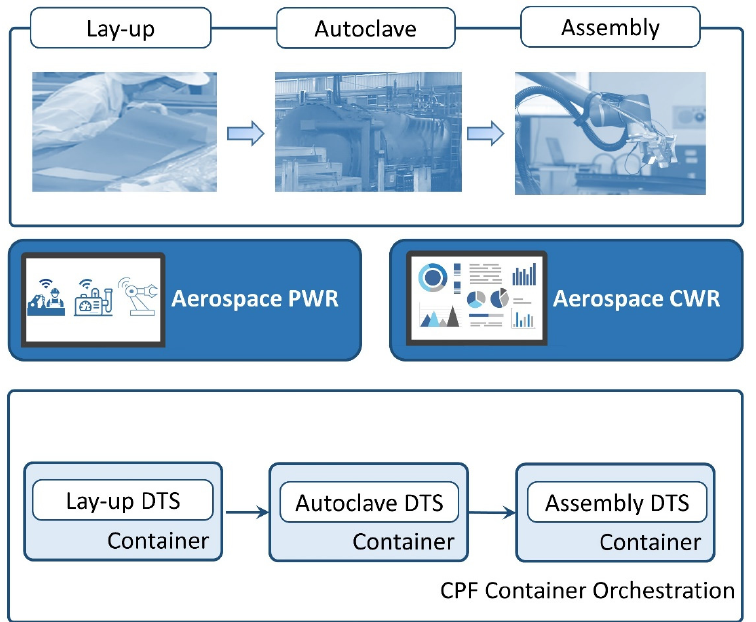
Figure 7. The three representative stages of the bonding process and the CPF in the aerospace man-